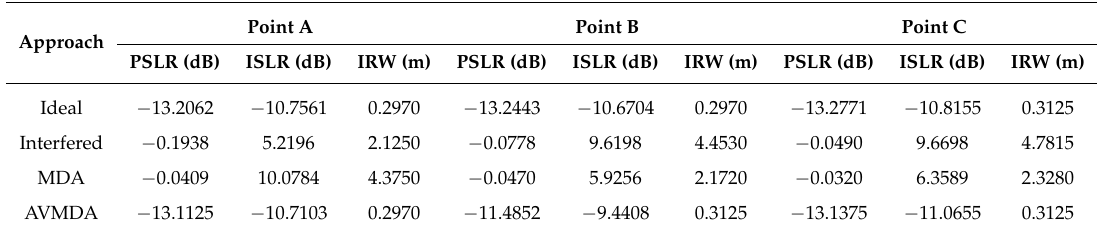
Figure 11. Azimuth impulse response curve comparison of Point A, B, and C. ( a ) Point A. ( b ) Point B. ( c ) Point C. Table 6. Statistical focus comparison of ideal, azimuth-variant error interfered, MDA processed, and AVMDA processed simulated point